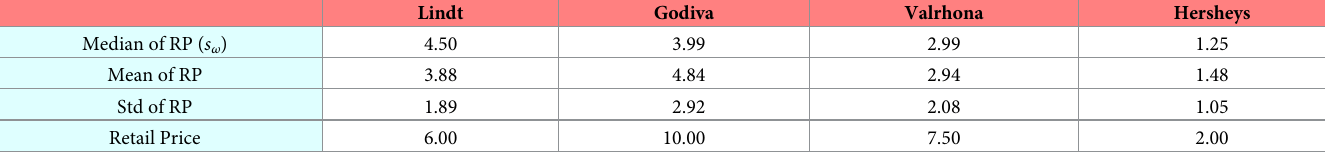
Table 4. Median, mean (+ std) RP for the chocolate in the four datasets, over the 722 consumers; also retail price for